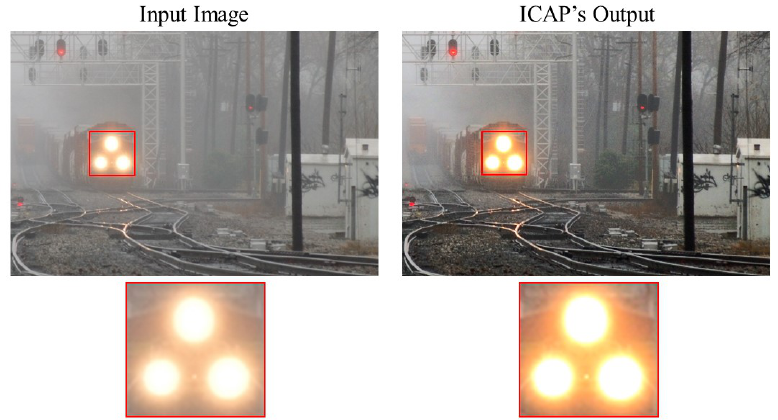
Figure 7. False enlargement problem shown by the train’s